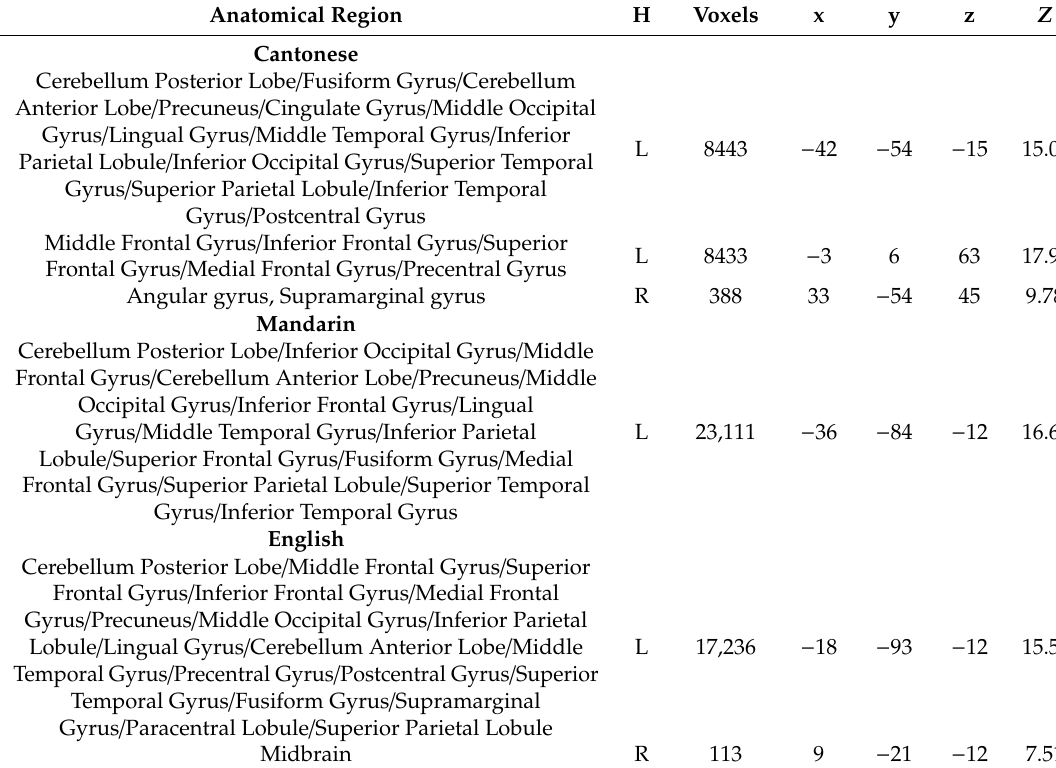
Table 3. Brain activity of Cantonese, Mandarin and English for the contrast of rhyming minus control in visual modality.